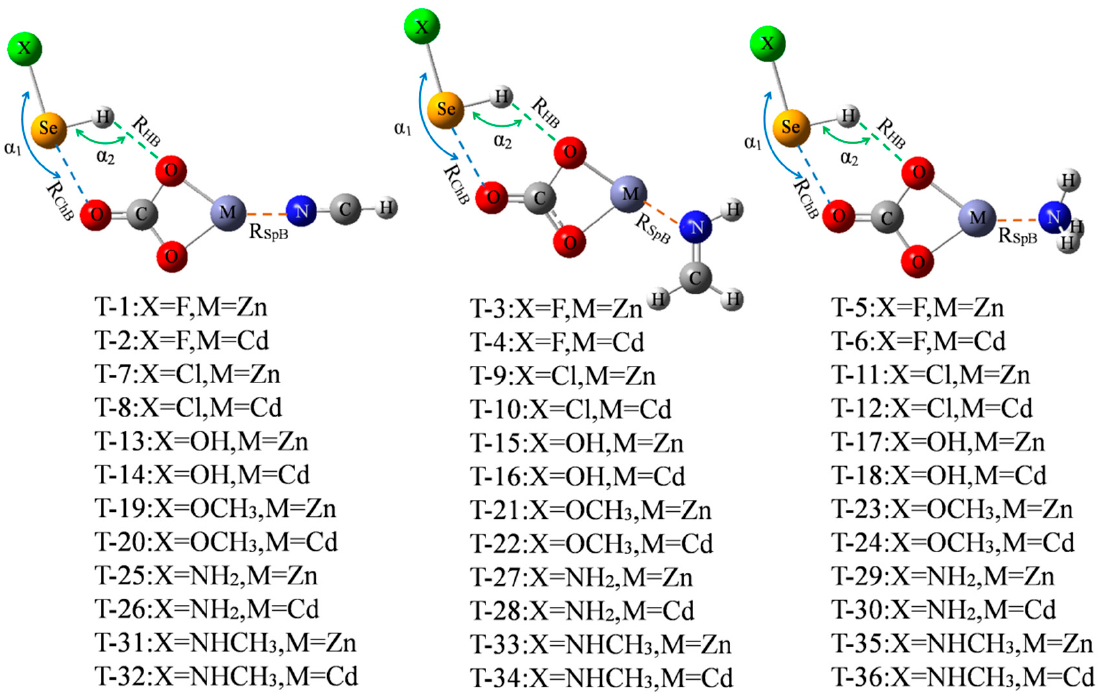
Table 5. Change of binding distance ( ∆ R, Å) in the triads relative to the corresponding dyads. HCN-ZnCO 3 -SeHF(T-1) −